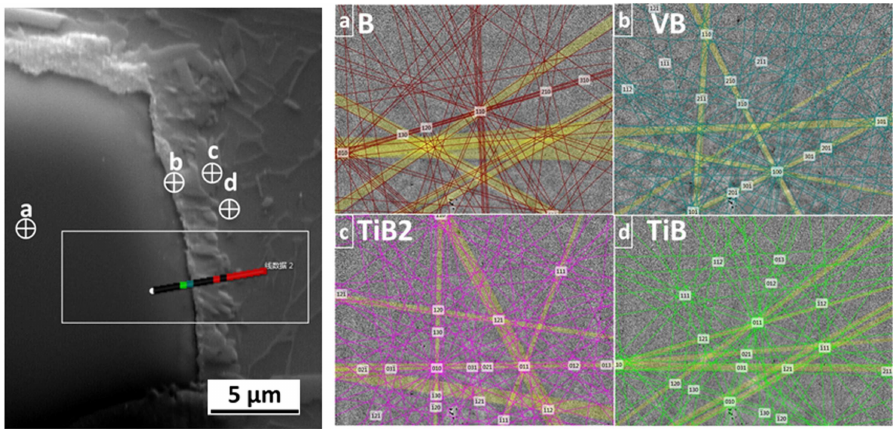
Figure 5. Micro-area EBSD phase analysis of the interface between C-B and the matrix. ( a ) C-B; ( b ) VB; ( c ) TiB 2 ; ( d )